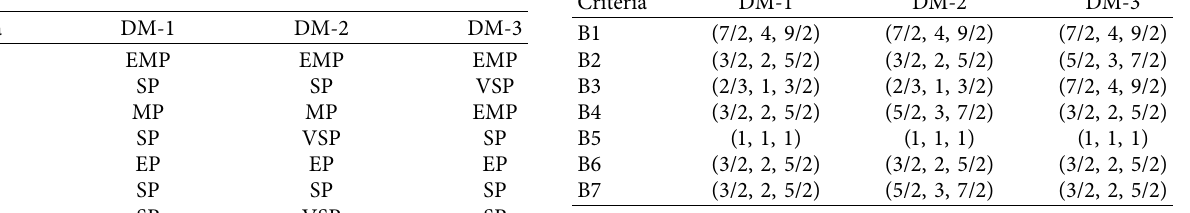
Table 4: Language preferences of decision-makers for the best criterion concerning each of the other factors (best-to-others vector).